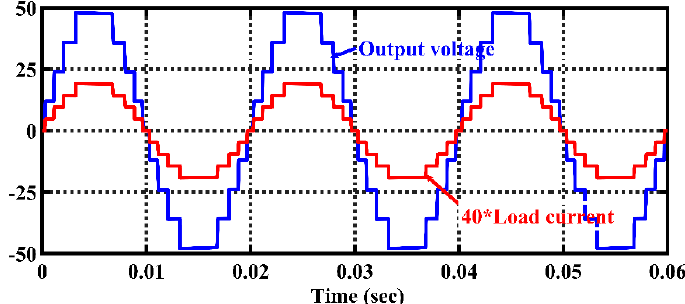
Figure 8. Output voltage and load current for symmetric configuration.